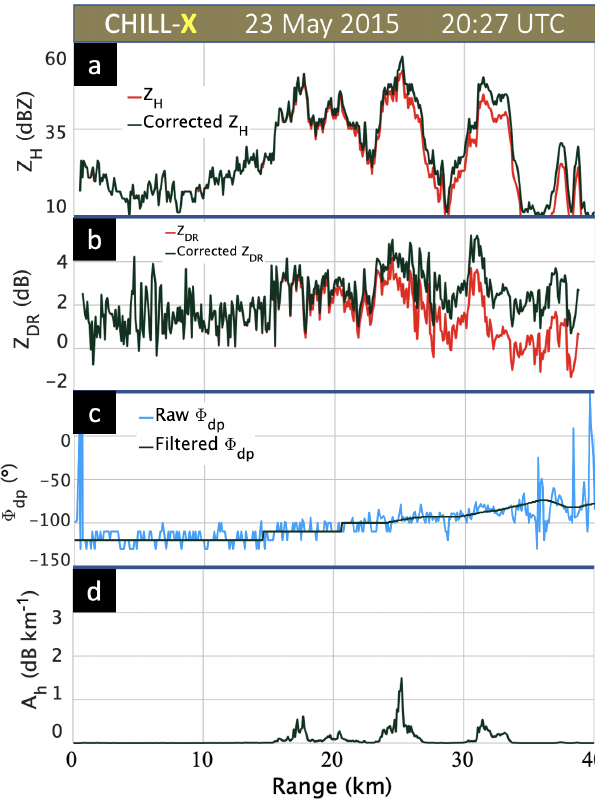
Figure 4. (a) Range profiles of measured and attenuation-corrected Z H at X-band at 20:27UTC at an azimuth angle of 171 ◦ (eleva- tion angle of 2 ◦ ). The Easton instrumented site is located at a range of 13 km, (b) measured and attenuation-corrected Z DR at X-band, (c) measured and filtered (cid:56) dp , and (d) specific attenuation ( A h ).